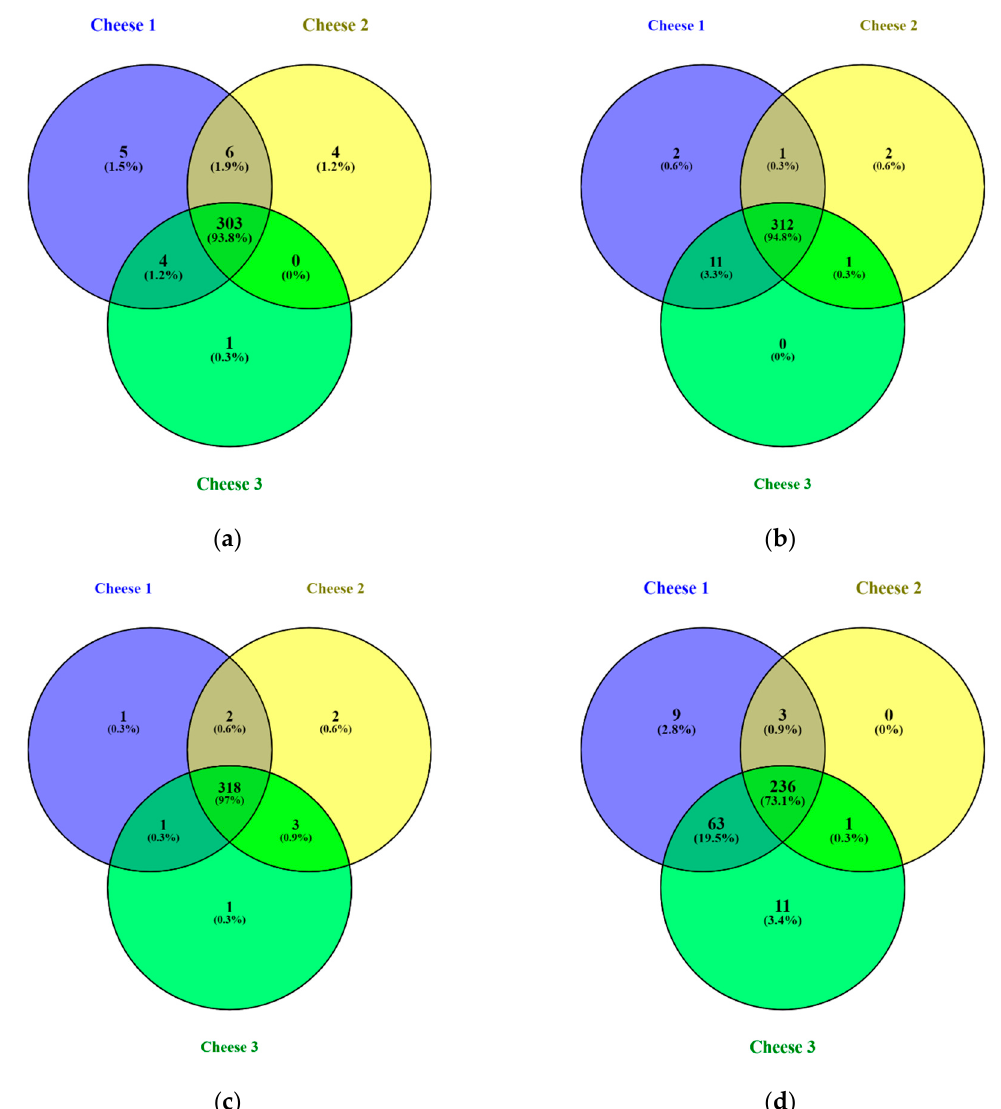
Figure 2. Venn diagrams of peptide distribution for Cheese 1, 2 and 3: ( a ) 0 days of ripening, ( b ) 14 days of ripening, ( c ) 30 days of ripening, ( d ) 90 days of ripening. Percentages in brackets denote proportion of all identified peptides across all cheeses.